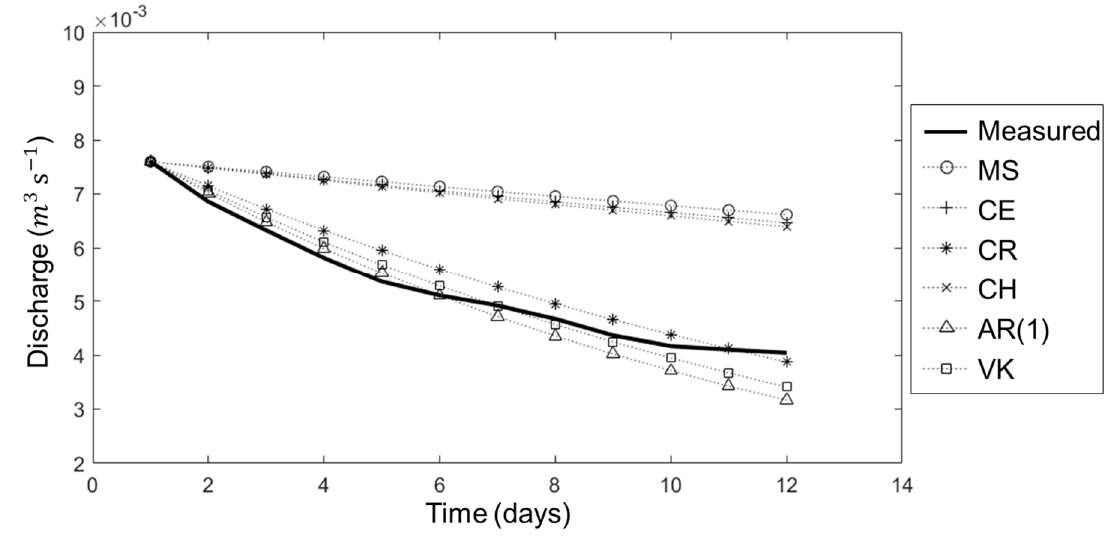
Figure 8. The real measured recession with calculated recessions by six estimation methods. The MS, CE, and CH methods tend to overestimate the recessions, whereas the CR, AR (1), and VK methods described the recessions relatively well.